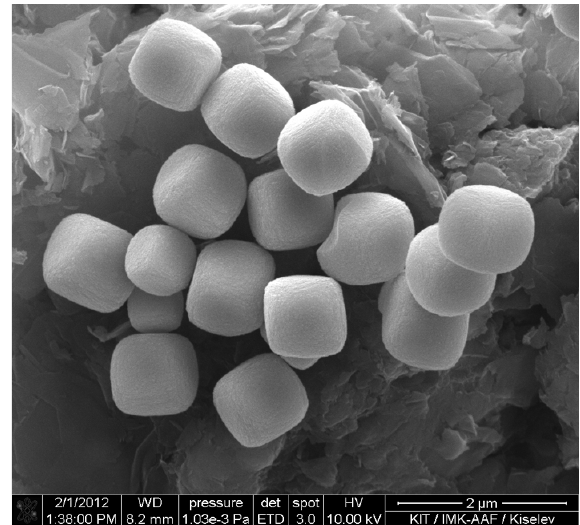
Fig. 2. SEM image of hematite particles on